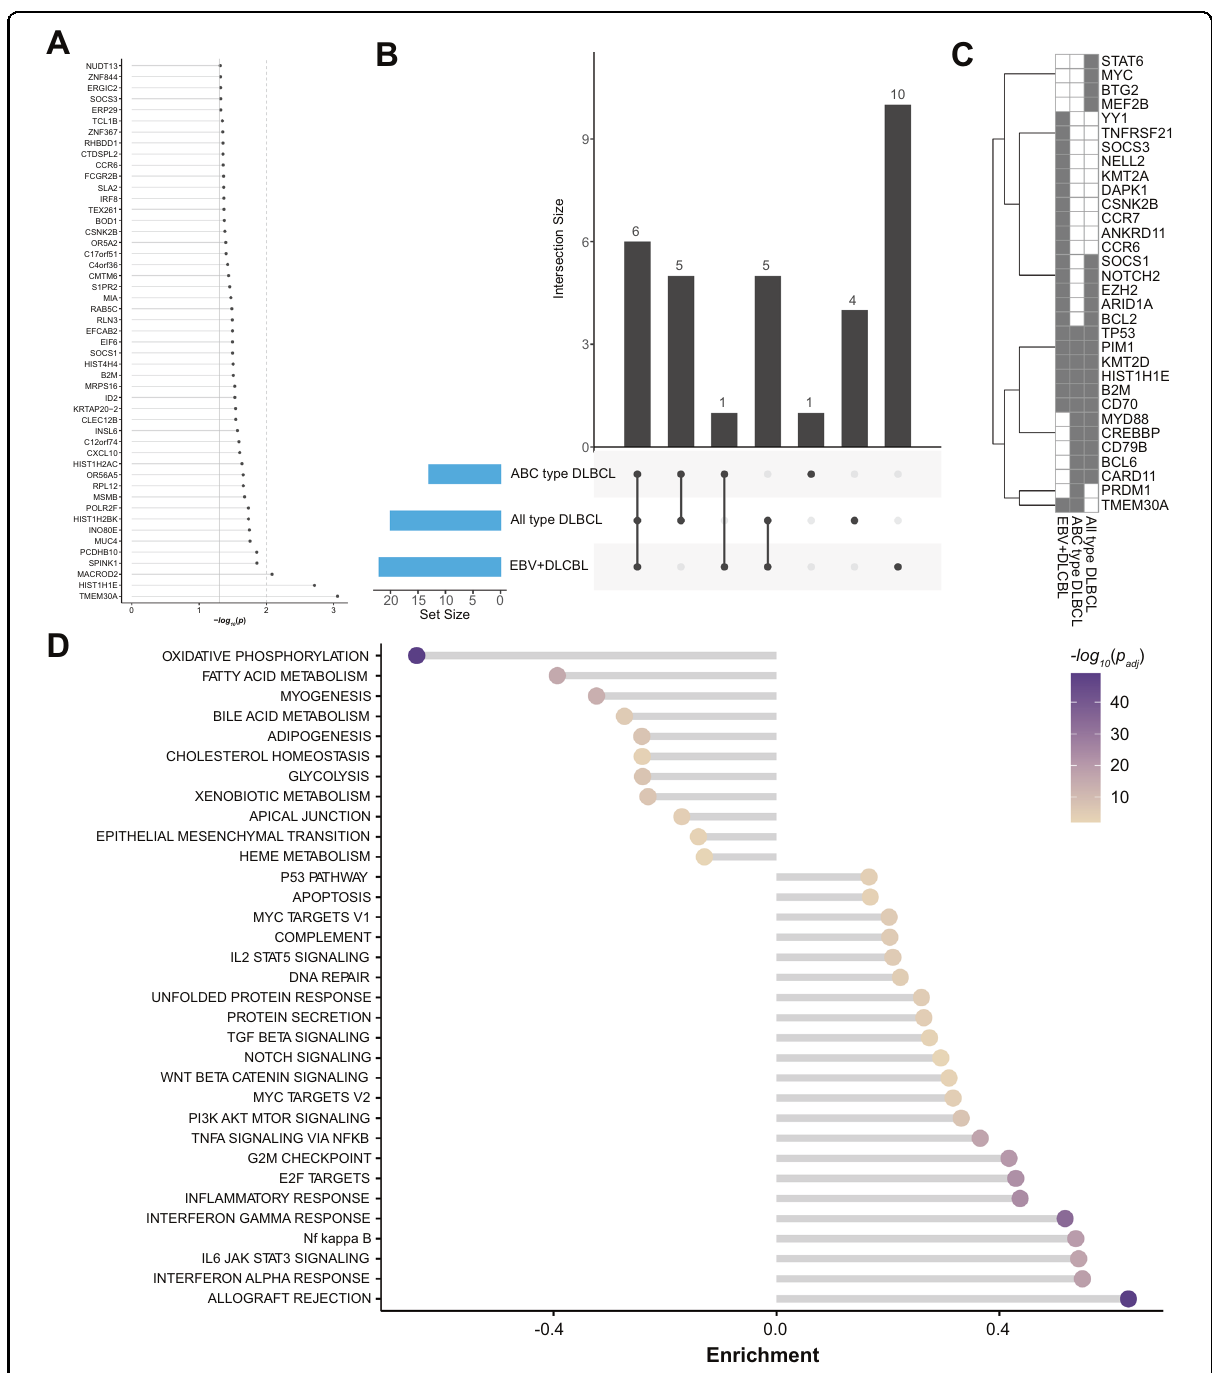
Fig. 4 MutSigCV analysis for variant calling. A Signi fi cance levels for all EBV + DLBCL (NOS) MutSigCV genes ( P < 0.05) and UpSet plot ( B ) showing the overlap of MutSigCV genes using EBV + DLBCL (NOS), all-type DLBCL and ABC-type DLBCL data; C shows the overlap between the three tumor entities. D HALLMARK gene sets enrichment for network diffusion analysis of signi fi cant MutSigCV genes (MutSigCV P <